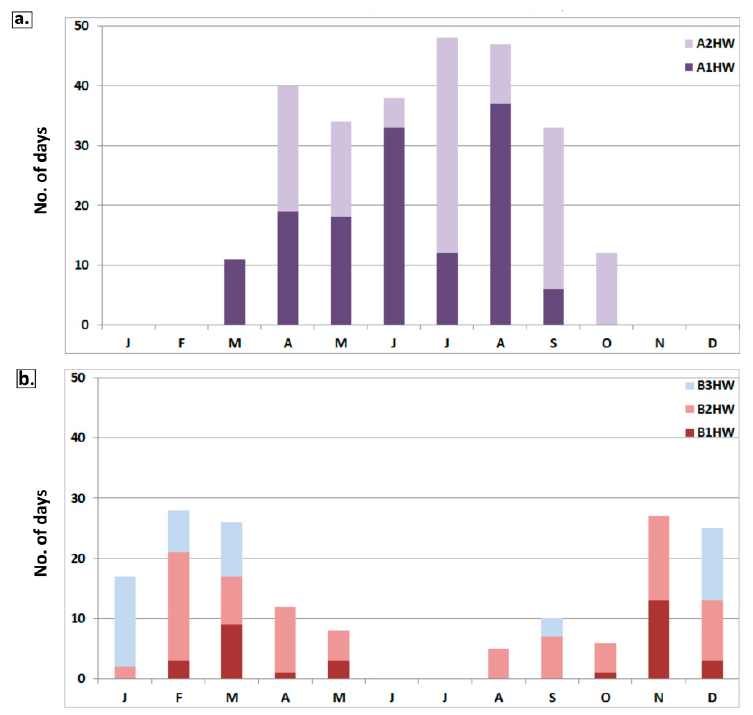
Figure 8. Absolute monthly frequency of HWs/WSs days in Romania (1961-2015) during ( a ) radiative sub-types; and ( b ) advective sub-types.